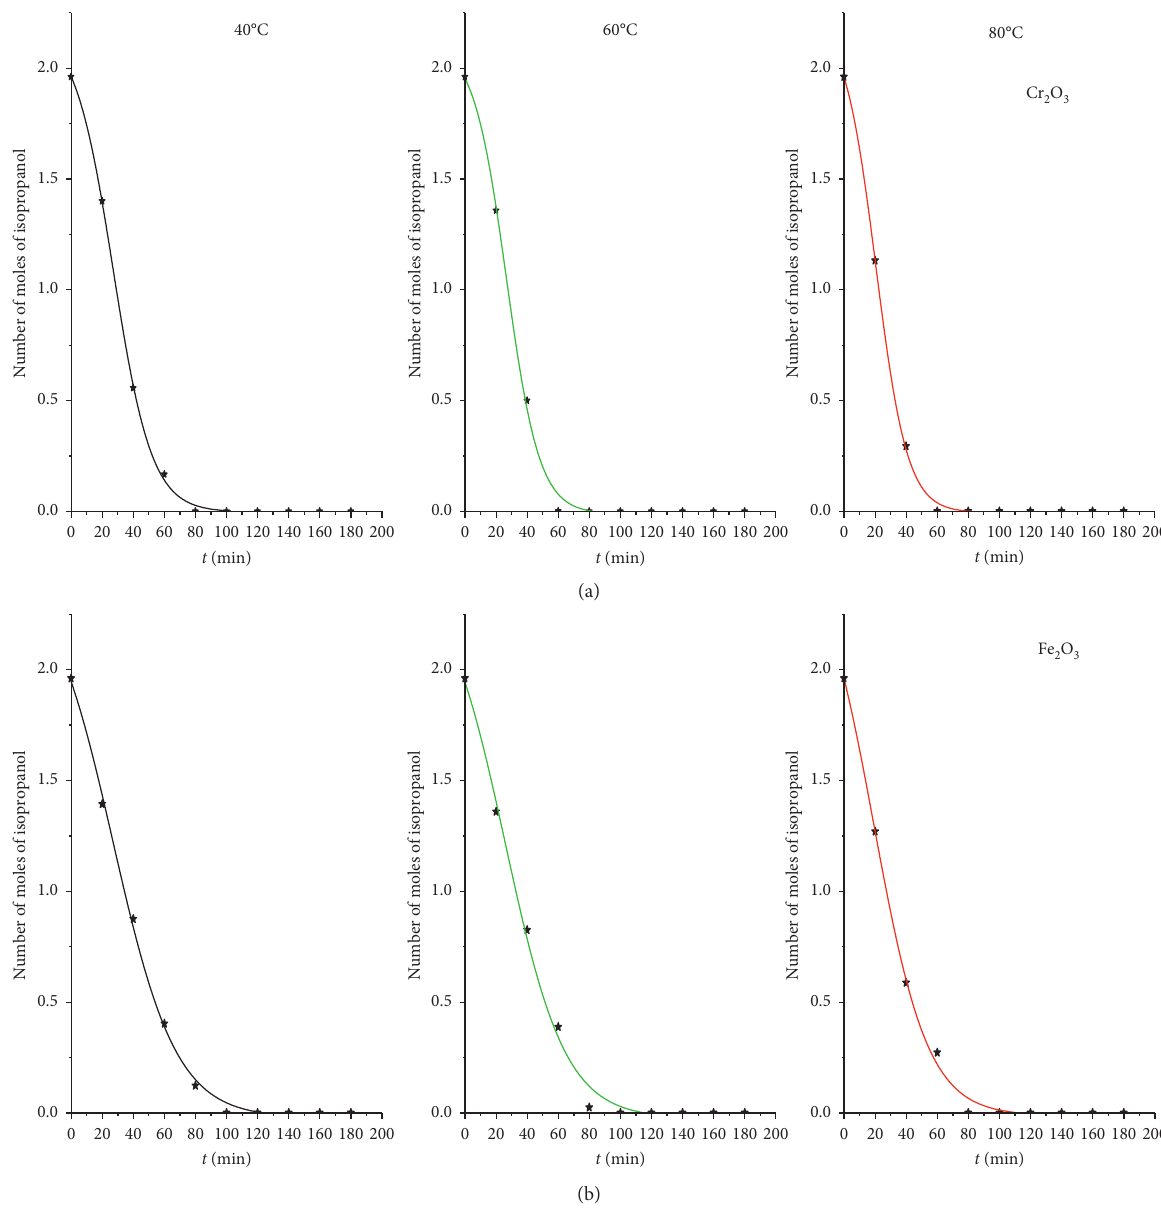
Figure 5: Moles number of isopropanol as a function of time in the presence of Cr